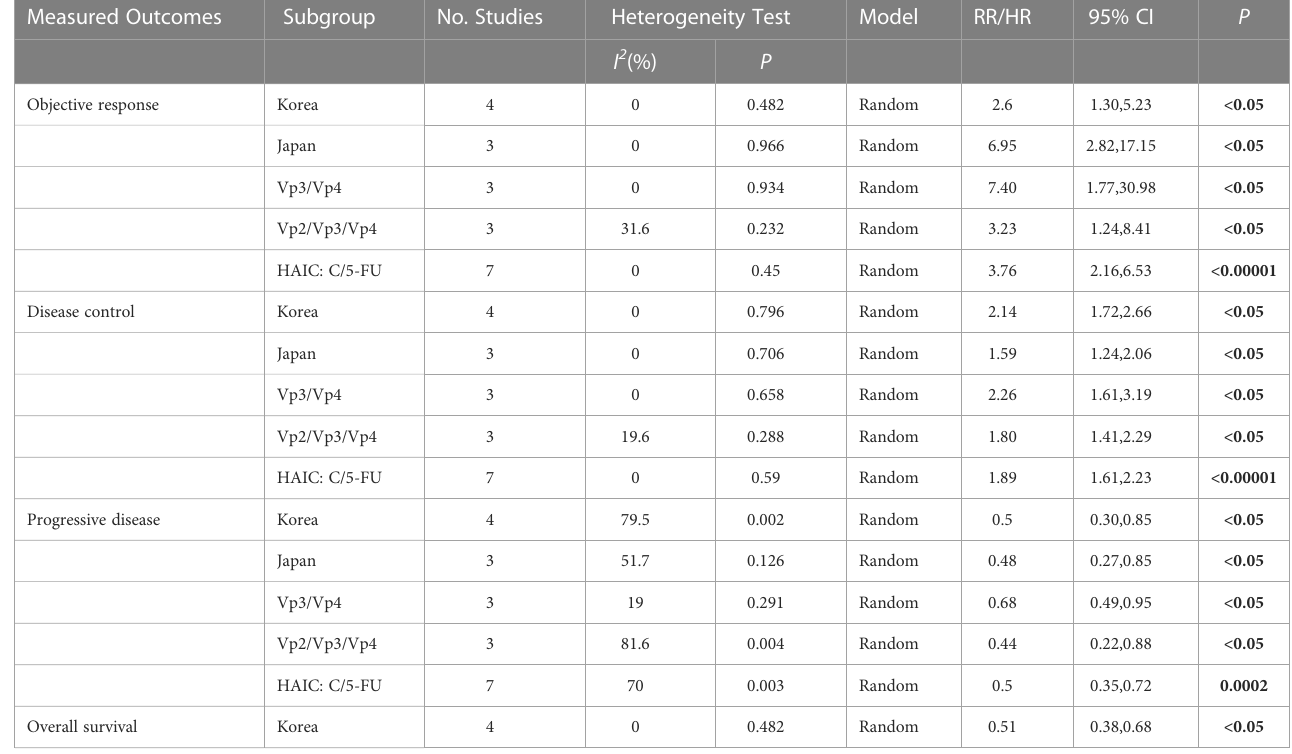
TABLE 5 Subgroup analysis results of all available studies in measured outcomes. Measured